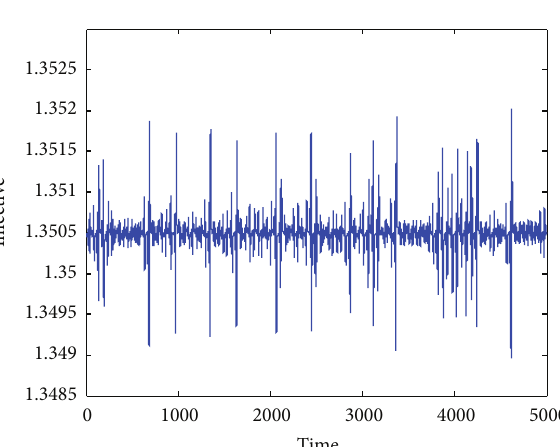
Figure 2: Time series of infective individuals.